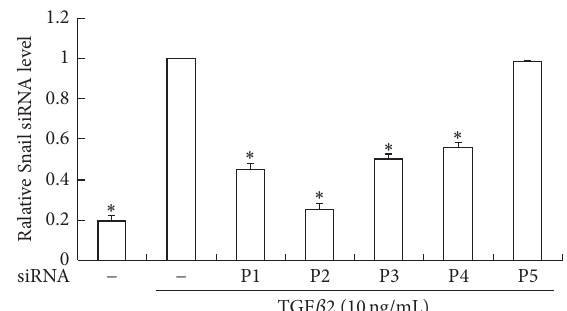
Figure 4: Efficiency of four siRNAs (P1–P4) on Snail expression. Serum starved HLEB3 cells were transfected with human Snail siRNAs (P1–P4) and negative control (P5) before being stimulat- ed with TGF 𝛽 2 for 1 hour. Snail expressions were significantly decreased with the siRNA treatment. The data were collected from 3 experiments. ∗ 𝑃 < 0.05 compared with siRNA ( − )/TGF 𝛽 2 (+) (10ng/mL).